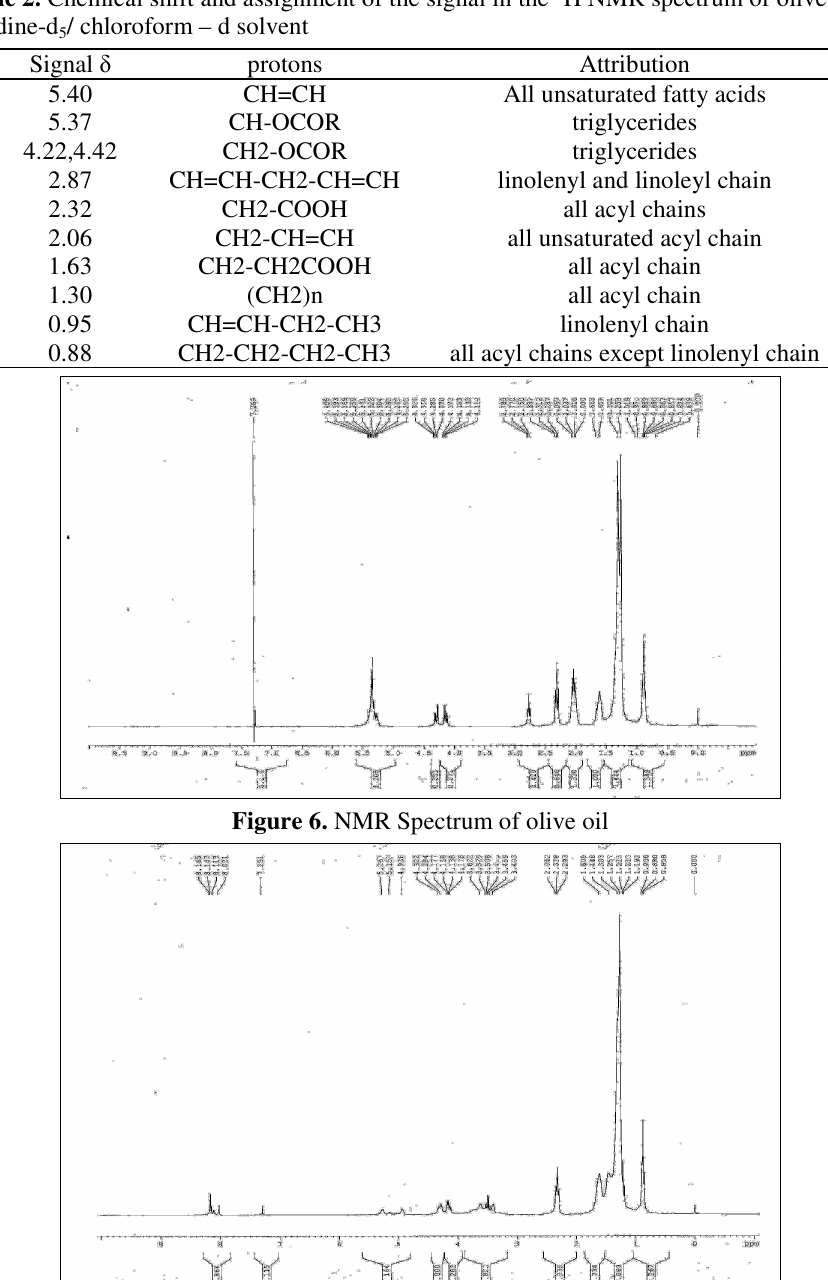
Figure 7. NMR spectrum of hydroxylated olive